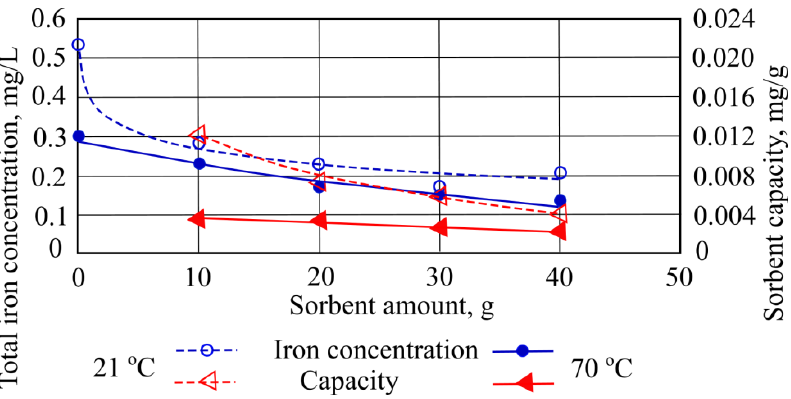
Figure 9. Total iron concentration and sorption capacity of mineral granulated sorbent.